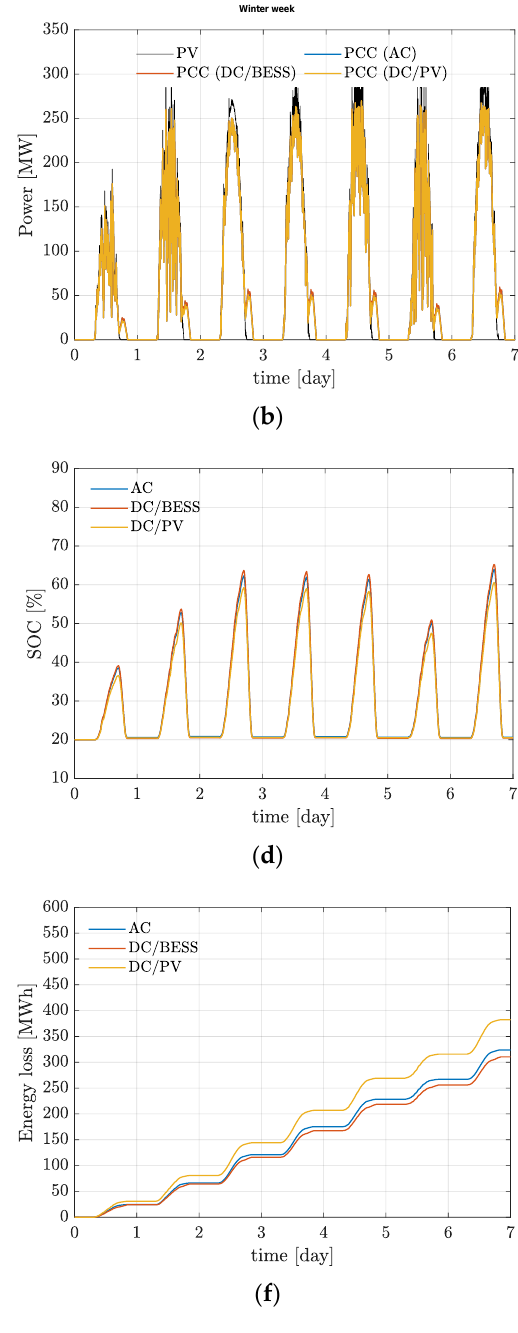
Figure 11. Power and SOC profiles for the three different layouts during typical summer and winter weeks. ( a ) grid power during summer week, ( b ) grid power during winter week, ( c ) battery SOC during summer week, ( d ) battery SOC during winter week, ( e ) total energy loss during summer week, ( f ) total energy loss during a winter week.